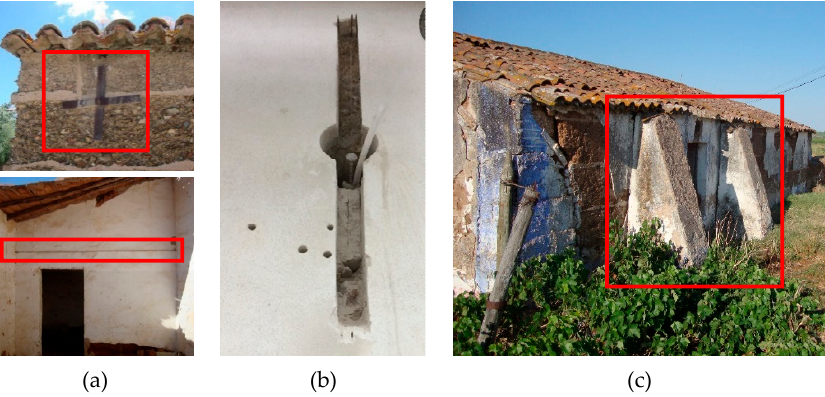
Figure 7. Examples of traditional strengthening solutions: ( a ) steel tie, ( b ) installation of an anchor system and ( c ) buttresses.